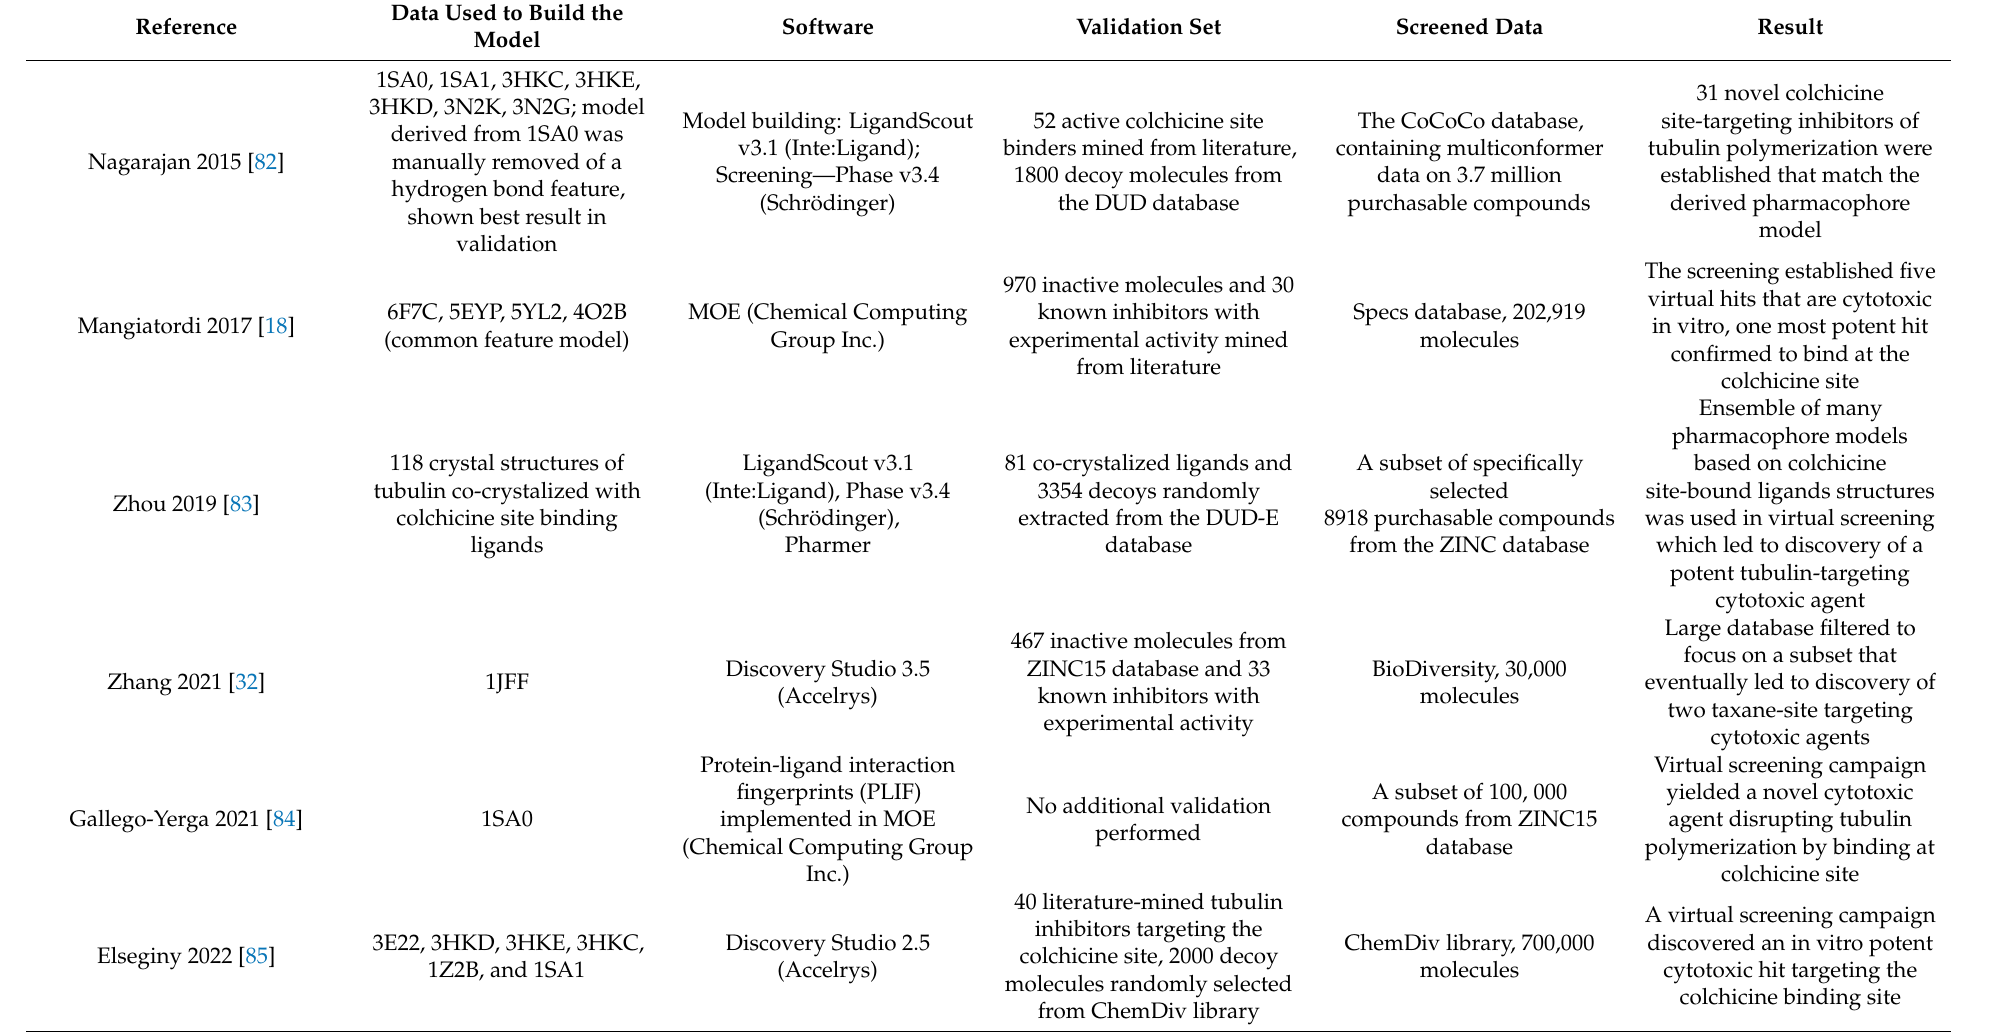
Table A4. An overview of structure-based pharmacophore screening